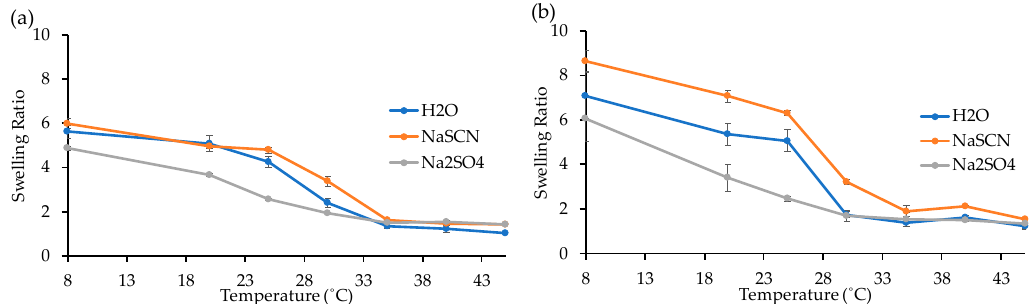
Figure 6. Evolution of the SR as function of the temperature for gel G2F ( a ) and G2R ( b ).